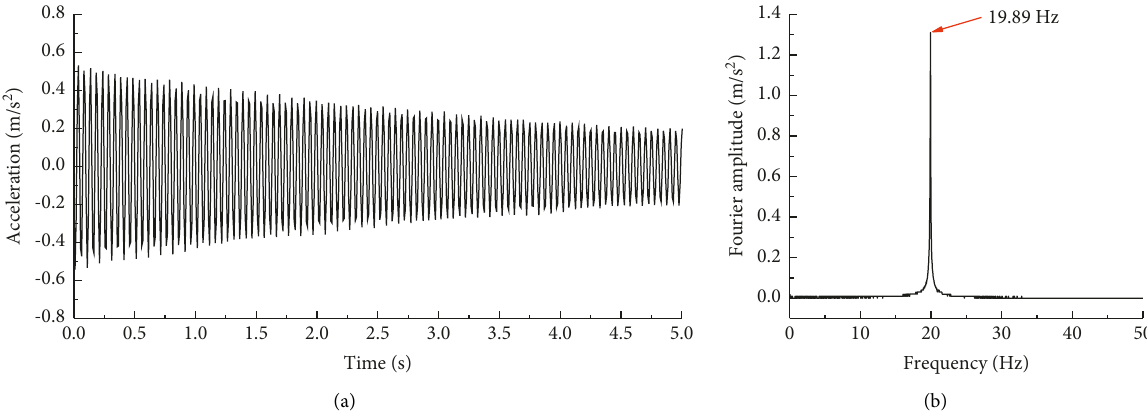
Figure 7: Frequency identification of model II. (a) Acceleration time history. (b) Fourier